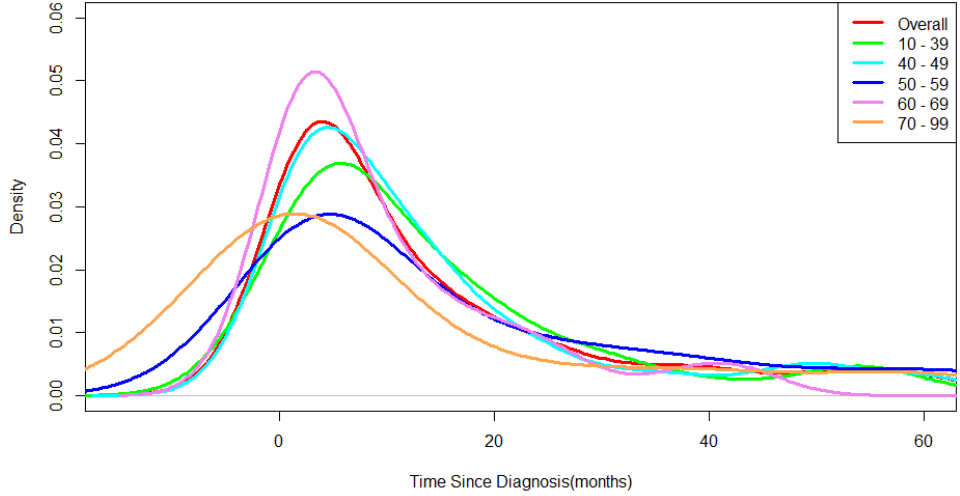
Figure 2. The frequency density of mental disorders, stratified by age group in breast cancer patient. The frequency density by disease also peaked within 2 months after diagnosis (Fig- ure 3). There was a difference in the peak times of the mental disorders. Depression and anxiety frequency peaked at the time of breast cancer diagnosis, whereas stress peaked at 2 months after diagnosis of cancer. The condition with the highest rate of increase after cancer diagnosis was found to be stress/adaptation disorders.